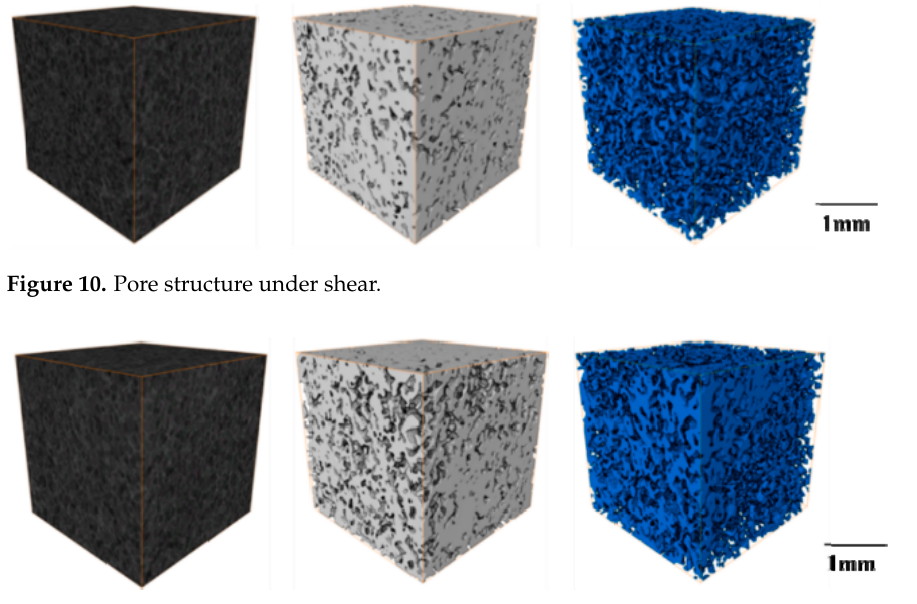
Figure 11. Pore structure in the absence of shear.